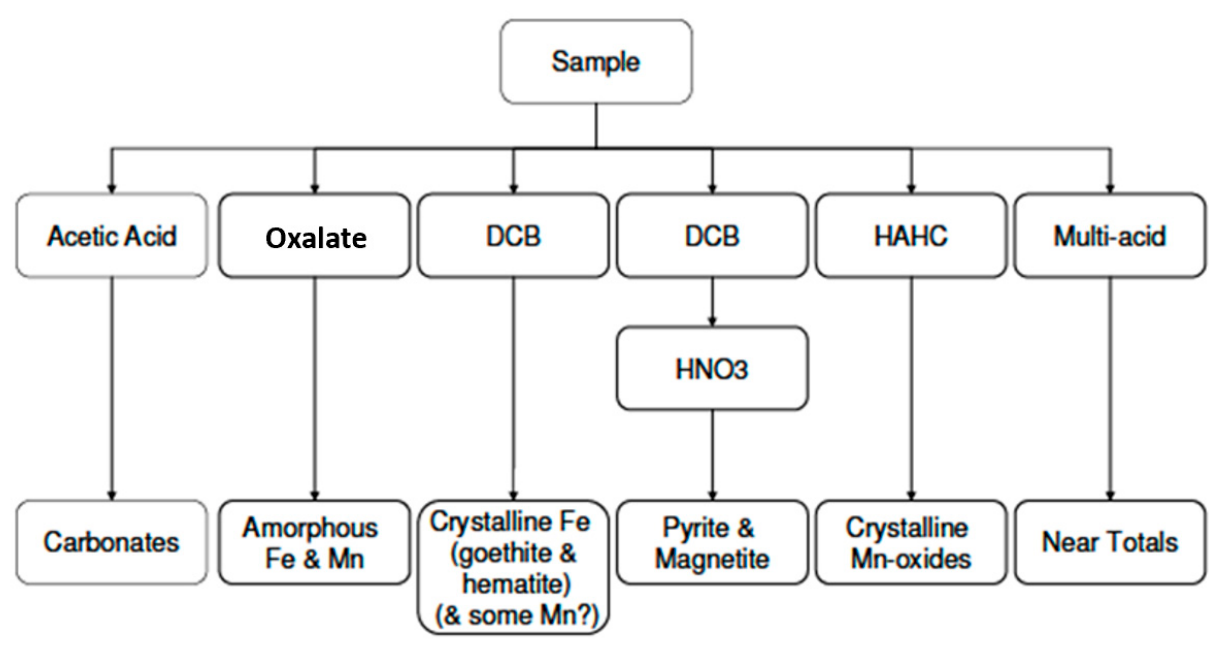
Figure 4. Selective Extraction Scheme.